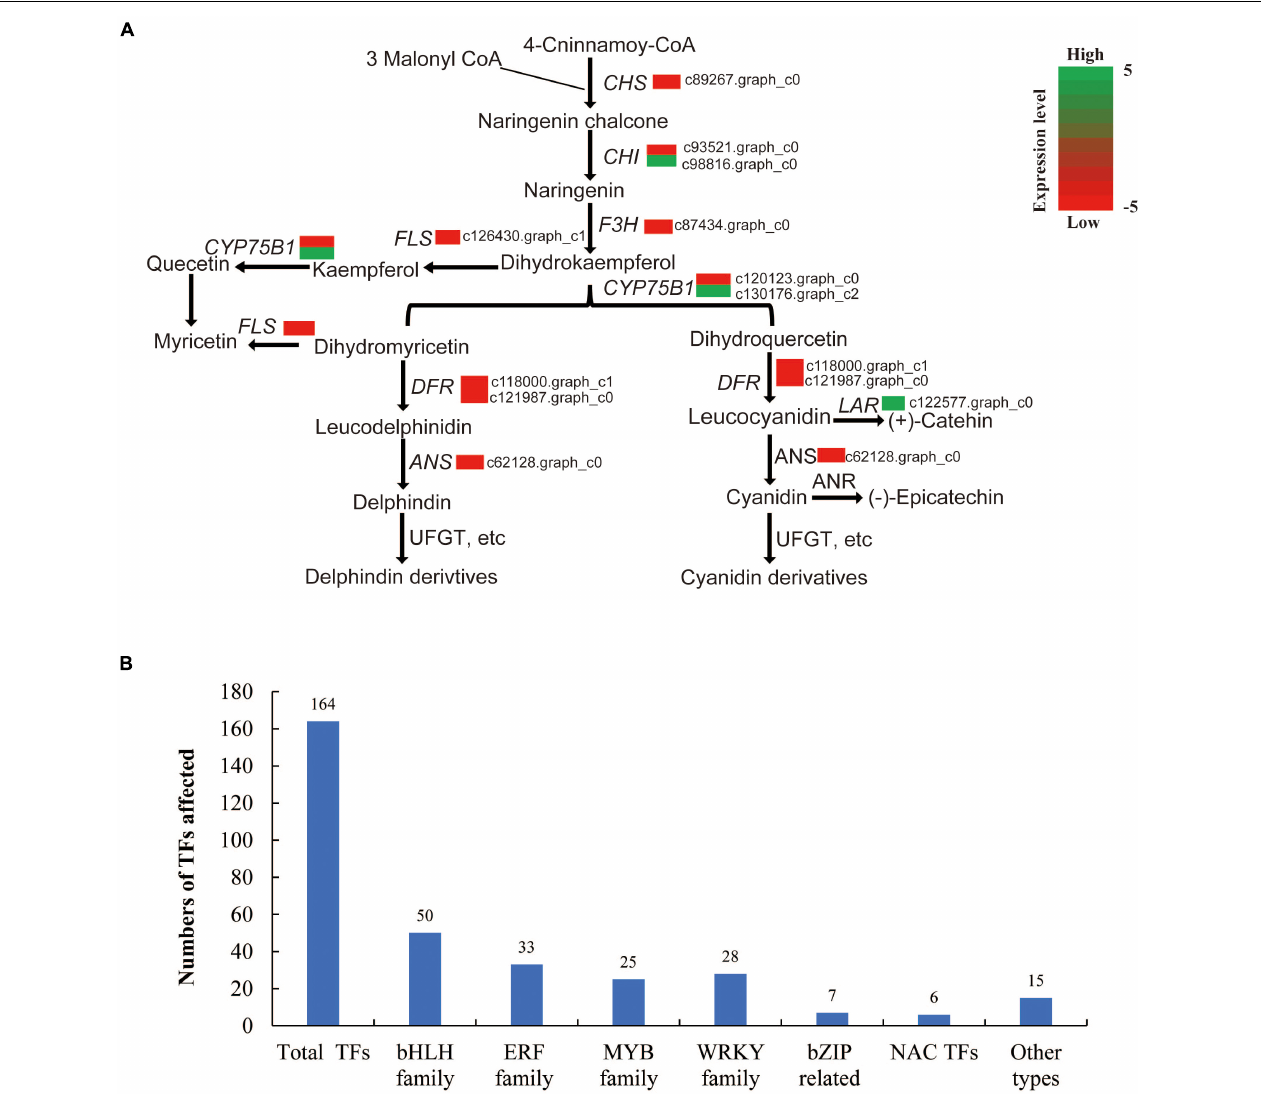
FIGURE 5 | Genes involved in flavonoid biosynthesis and total transcription factors (TFs) identified in RNA-seq. (A) Genes involved in flavonoid biosynthesis. (B) An overview of the total number TFs in this study.